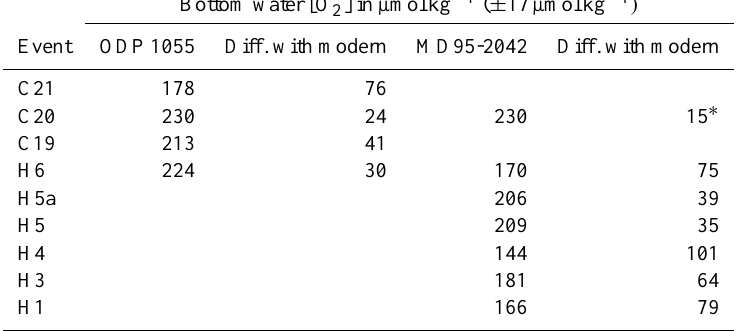
Table 1. Lowest bottom water [O 2 ] associated with Heinrich and extreme cool events and the difference with modern time at intermediate North Atlantic ODP Site 1055 (254µmolkg − 1 today) and deep North Atlantic site MD95-2042 (245µmolkg − 1 today). Note that [O 2 ] at MD95-2042 during cold event C20 (indicated with ∗ ) is not significantly different from that at modern